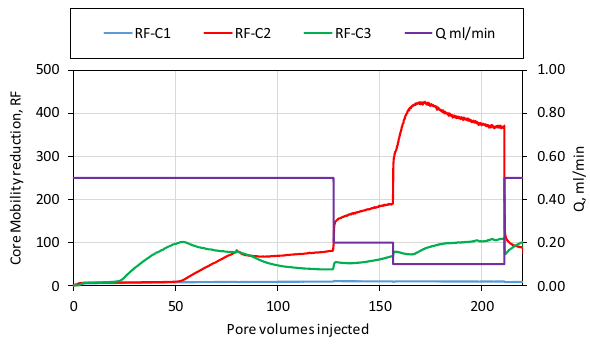
Fig. 15 Experiment 7, 1000 ppm A10 in SSW in Sand column. RF RF pm and CT as a function of pore volumes injected in the sec- tions. T = 80 °C. The volumetric injection rate is 3.0 ml/min ( ̇𝛾 pm ∼ 40s − 1 , ̇𝛾 ct = 495s − 1 ) from 0 to 262 pore volumes. The black dots indicate when the polymer solution reservoir was